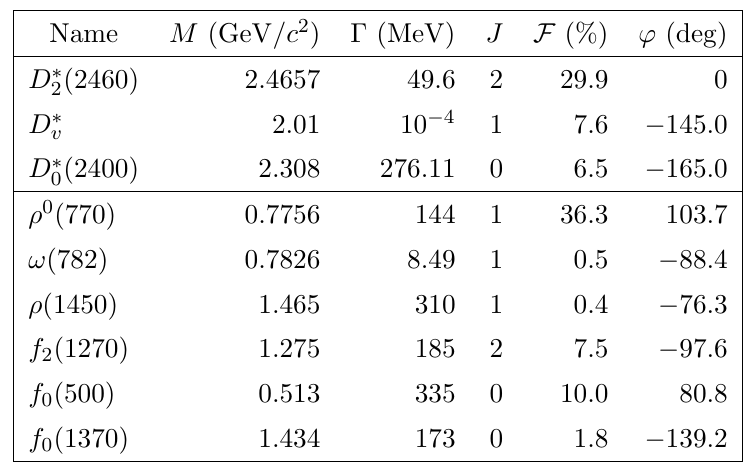
Table 4 . List of resonances included in the B 0 D 0 (cid:25) + (cid:25) (cid:0) decay amplitude model. The resonance ! (cid:12)t fraction is denoted by and the resonance amplitude phase is denoted by ’ . F